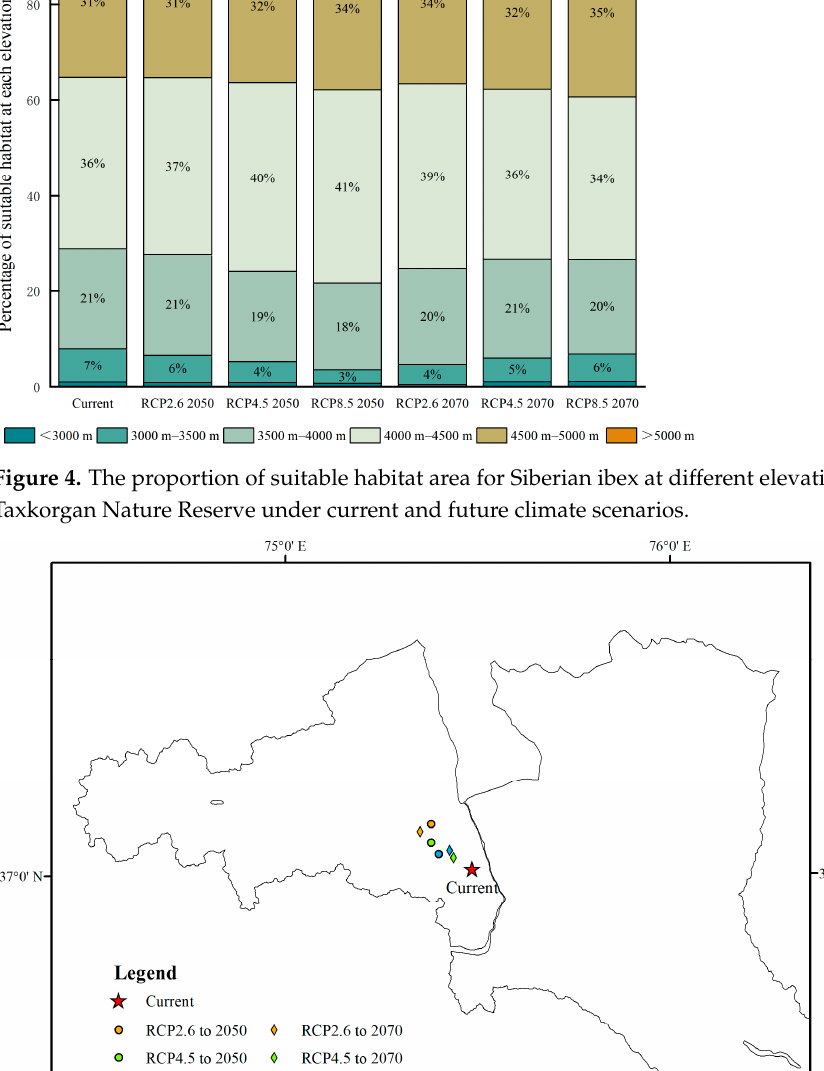
Figure 5. Centroid distribution of suitable habitat for Siberian ibex in Taxkorgan Nature Reserve under current and future climate scenarios. The average shift to the north is 5.81 km when the latitude difference is taken into account, and 10.20 km in the RCP2.6 for 2050.